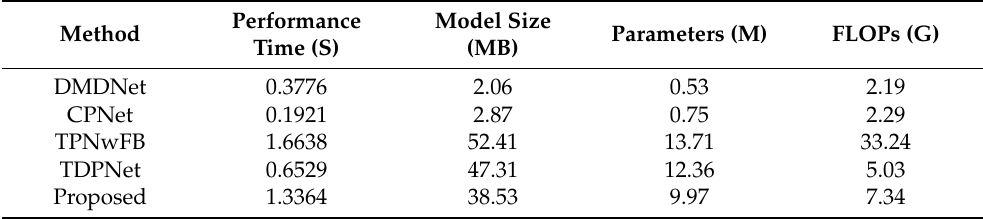
Table 8. Comparison of different deep learning methods in terms of perform time, model size, number of parameters, and floating-point operations per